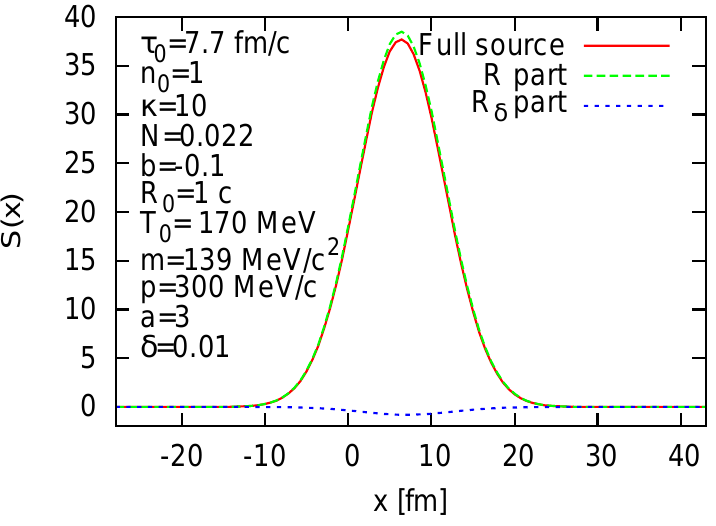
Figure 1. The two component Gaussian source at a given set of parameters denoted on the label. Furthermore, T eff and T δ are effective temperatures, corresponding to the inverse logarithmic slope of the Maxwell–Boltzmann like distributions. R and T eff are the same as in the original